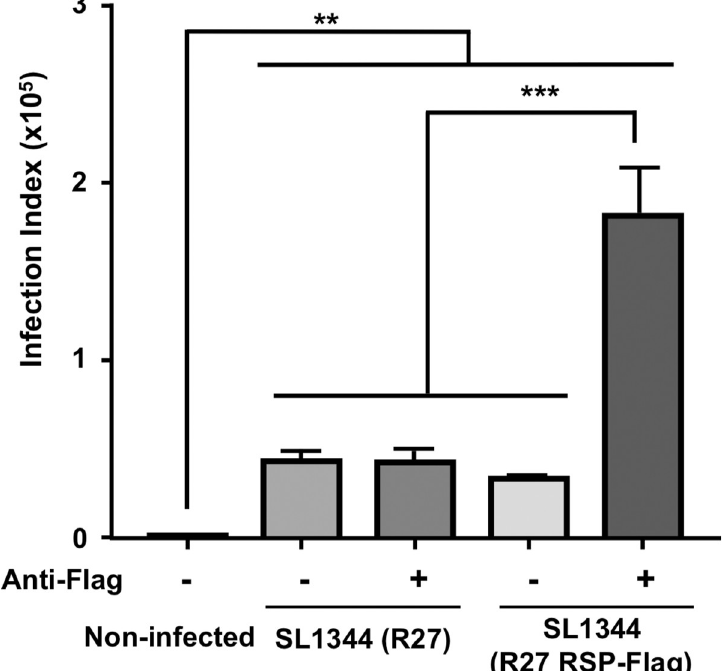
Fig 9. Opsonization of RSP-Flag enhances bacterial phagocytosis by macrophages. Strain SL1344 cells expressing either RSP (wild-type R27) or RSP-Flag (RSP-Flag R27) were opsonized with anti-Flag antibodies or left nonopsonized. Macrophages were infected for 30 min with Salmonella cells (either opsonized or nonopsonized) at an MOI of 15. Negative control cells were not infected. The results are the mean of 2 independent experiments each of which was performed using biological triplicates. One-way ANOVA, Tuckey´s post hoc ( ��� P < 0.0001; �� P < 0.01).